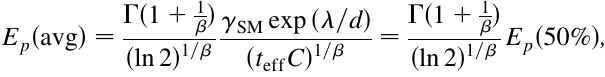
FIG. 3. The fractional standard deviation of the values of (cid:24) as a function of (cid:2) , for the 17 PMMA measurements listed in (cid:12) 10 (cid:11) s and 0 : 5 (cid:12) d (cid:12) 4 : 32 cm . The Table I with 0 : 5 ns (cid:12) t eff plot assumes (cid:9) (cid:9) 0 : 24 cm .